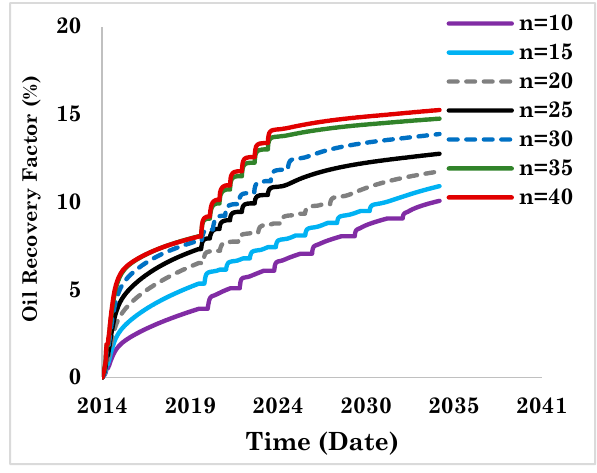
Figure 21. NG Injection (Extended Cycle Size) 31 API Oil.